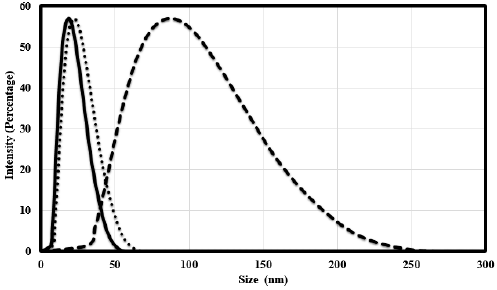
Figure 7. The particle size distribution profile of spherical silver nanoparticles coated with citrate ( ─ ), PVP ( ∙∙∙ ) and poly-Arg-PVP ( - - ) determined by dynamic light scattering.